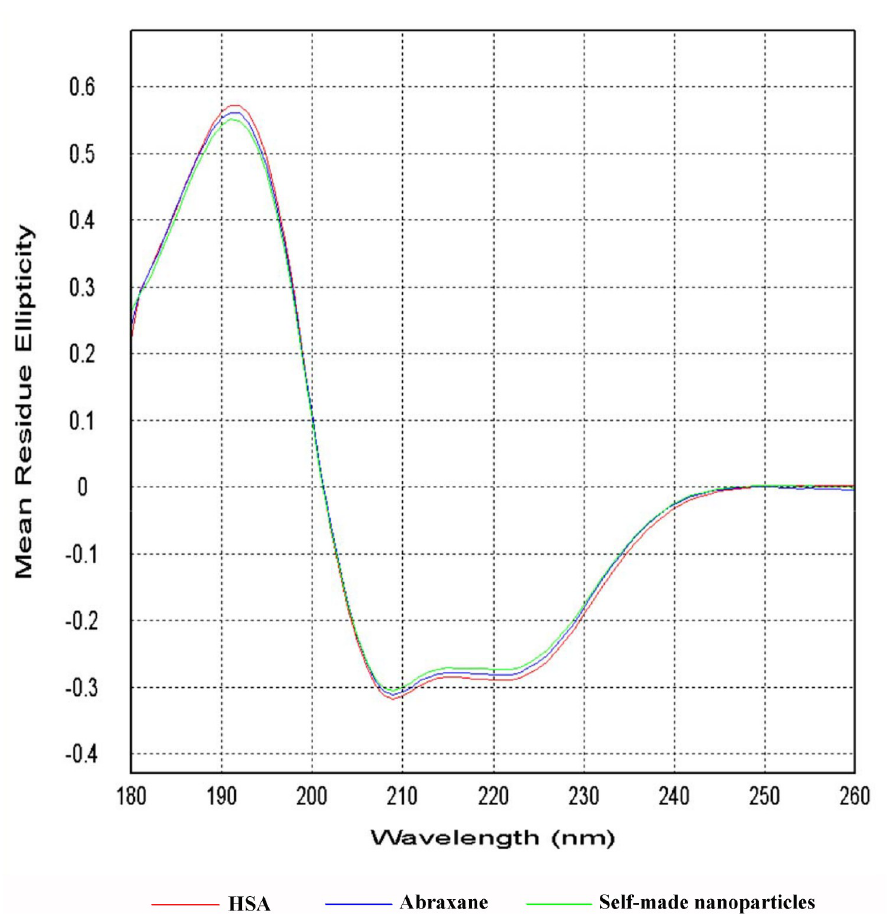
Fig 6. Far-UV CD spectra from 180nm to 260nm for blank HSA and HSA in Abraxane and self-made nanoparticles.